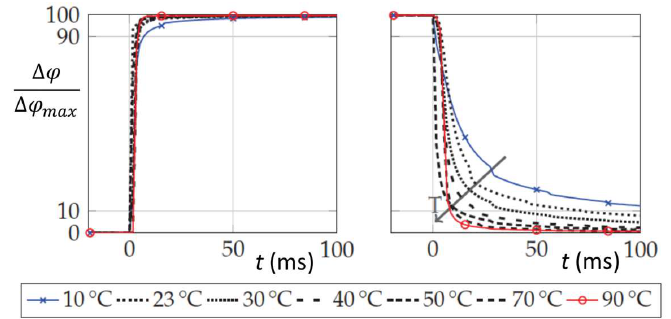
Figure 29. Transient behavior of the loaded-line phase shifter in MEMS technology with the rise and decay of the measured differential phase shift with respect to its maximum in percentage at 77 GHz versus time for different temperatures [268].